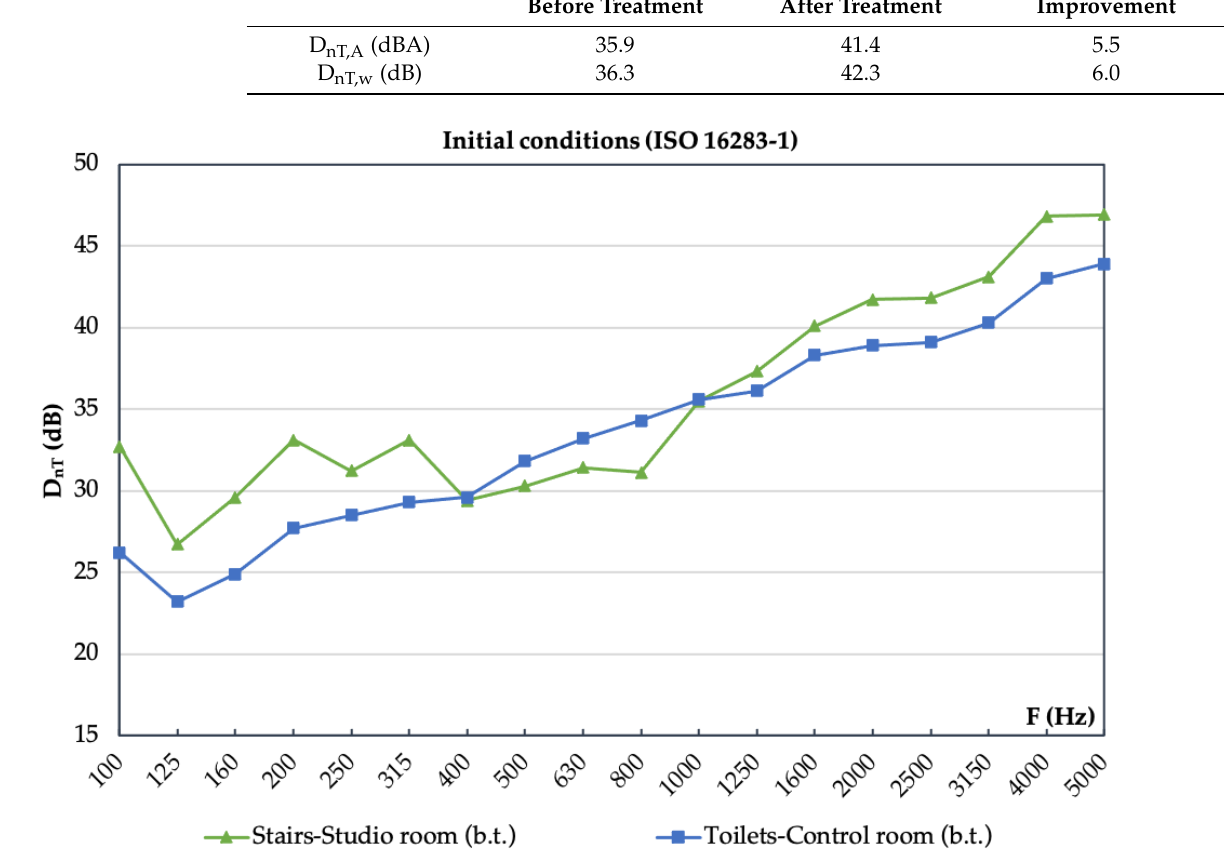
Figure 18. Standardized level difference of the toilets–control room vertical